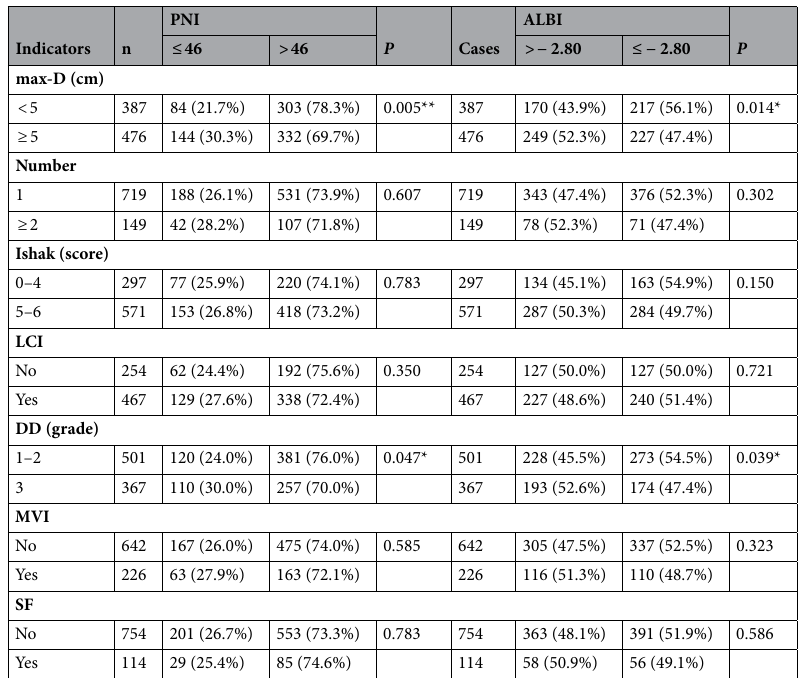
Table 2. The correlation analysis between PNI, ALBI and pathological qualitative